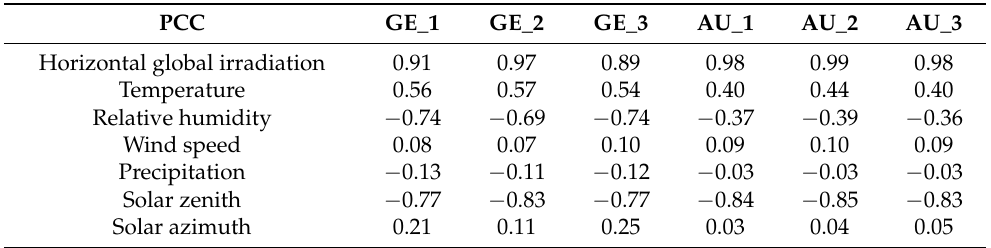
The correlation between PV energy production and the different meteorological vari- ables varies between the location, showing a different influence of these features depending on the climatic conditions. With respect to the correlation with the horizontal global irra- diation, it is stronger in the case of the facilities from Australia. Among the facilities in Germany, the highest correlation was found in the GE_2 facility. The differences in the correlations obtained may be due to several factors. First, the sky conditions in Konstanz are much more diverse than the sky conditions in Alice Springs, which has an impact in the relation between horizontal irradiation and plane-of-array (POA) irradiation [63], and therefore, in energy production. Secondly, the GE_1 and GE_3 installations are not oriented towards the south, but slightly towards the southwest, which produces a certain gap between the maximum generation and the maximum irradiation points, as shown in Figure 7. Thirdly, the tilt of the different systems is not the same: the lower the tilt, the greater the correlation. Finally, the facilities in Germany are located on roofs of urbanized areas, which results in a more obstructed horizon that also decreases the correlation. Finally, Figure 8 represents the relation between the PV energy production and the horizontal global irradiation for the different facilities, highlighting the differences between the months of the